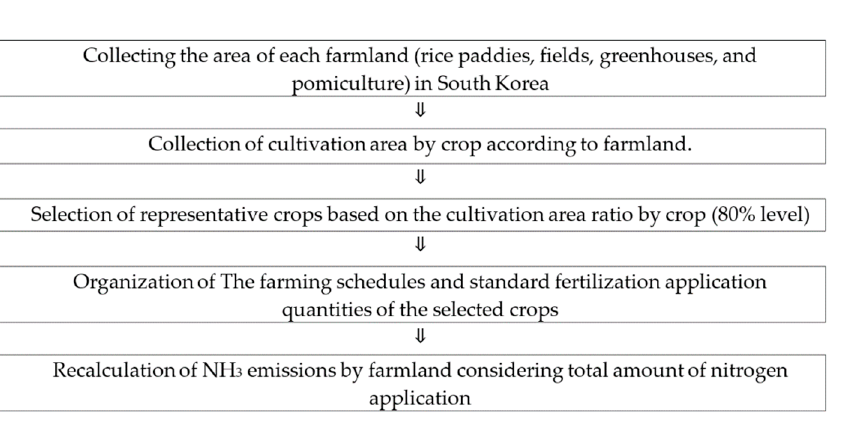
Figure 3. Spatial-Temporal resolution improvement work flow-chart (Method